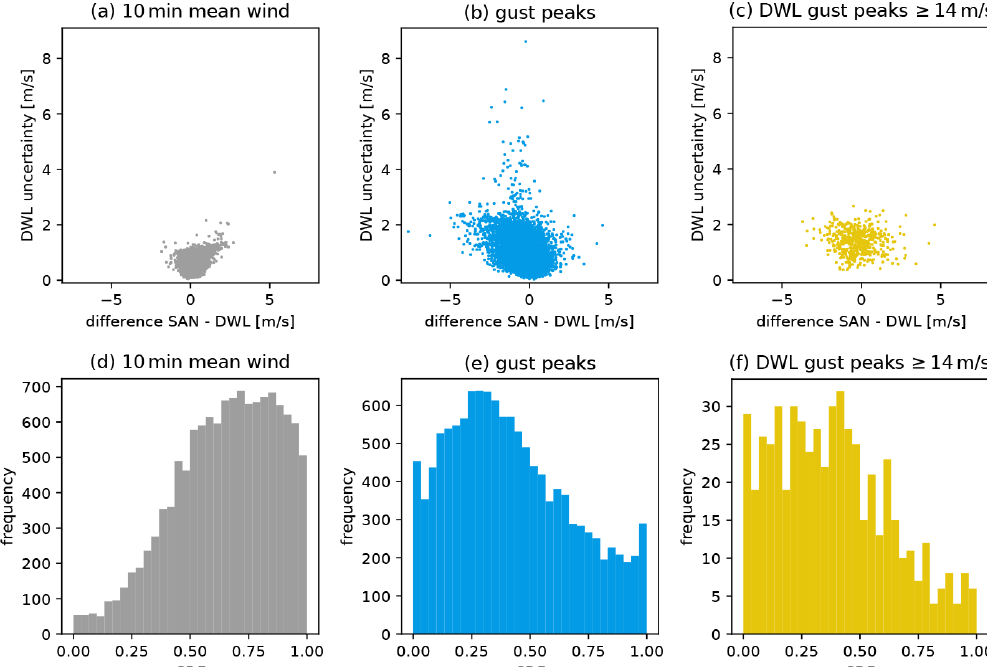
Figure 12. Examination of uncertainty. Panels (a) – (c) show comparisons for the differences of the sonic anemometer (SAN) and DWL wind values against the estimated DWL uncertainty. Panel (a) displays the results for the 10min mean horizontal wind, panel (b) for the gust peaks, and panel (c) for only cases in which the DWL gust peaks exceed 14ms − 1 . Panels (d) – (f) show the rank histograms for the retrieved DWL wind and its corresponding uncertainty; panel (d) addresses the 10min mean horizontal wind, panel (e) gust peaks, and panel (f) the gust peaks exceeding 14ms − 1 . Each histogram shows the frequency of the Gaussian wind cumulative distribution function values, evaluated at the sonic anemometer observations. A perfect model would show equally distributed